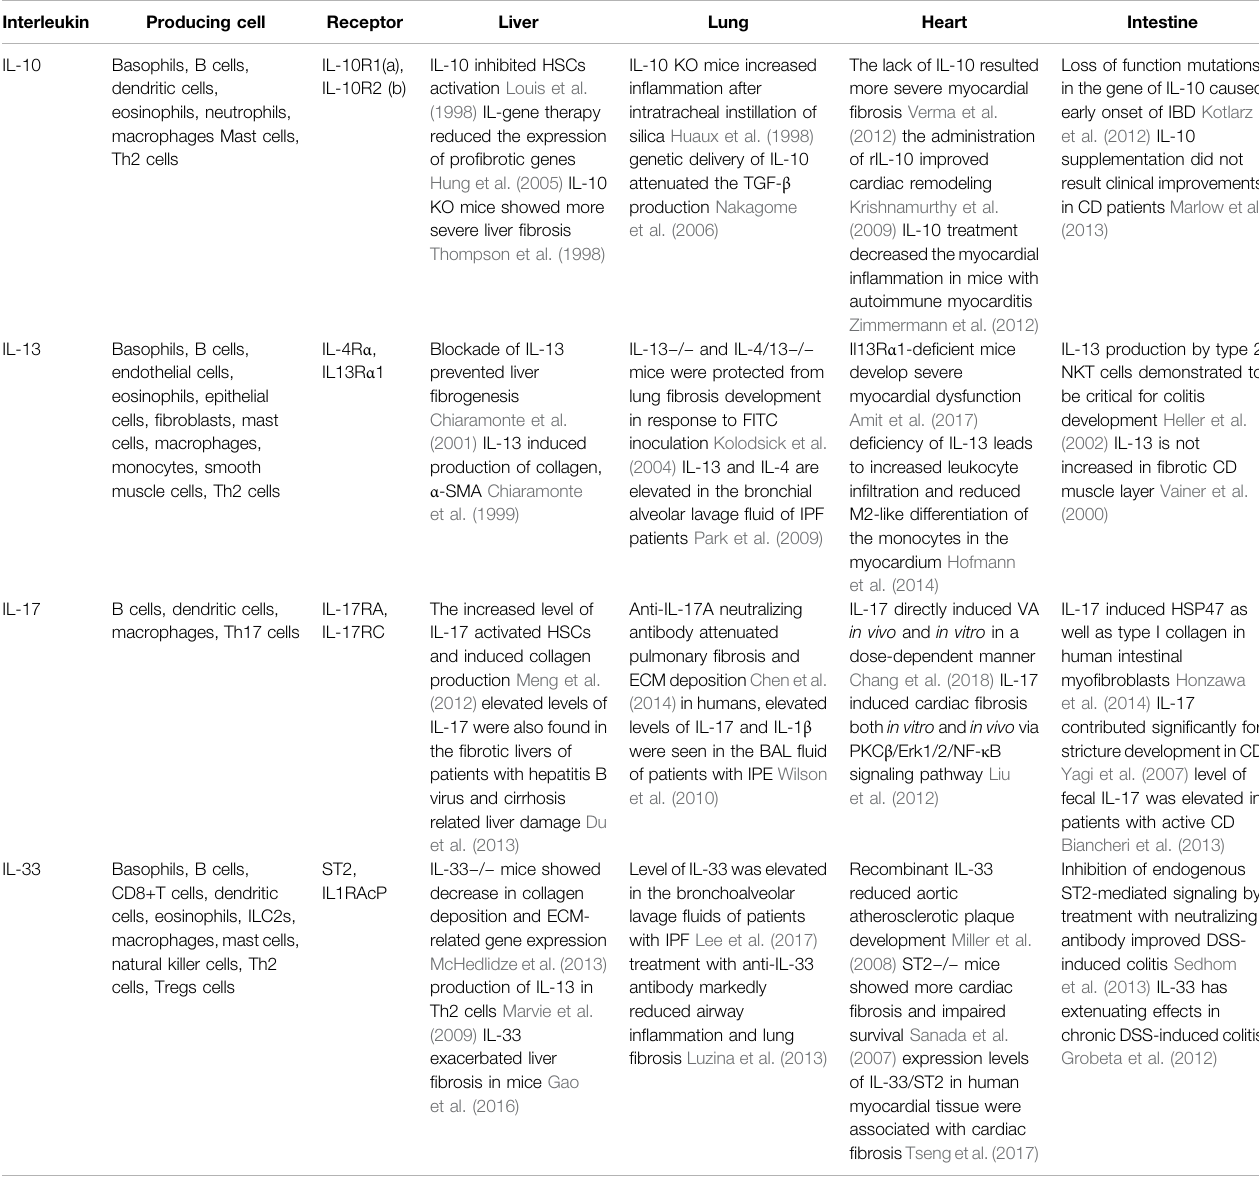
TABLE 2 | Roles of IL-10, 13, 17, and 33 in fi brotic disease. Interleukin Producing cell Receptor Liver Intestine